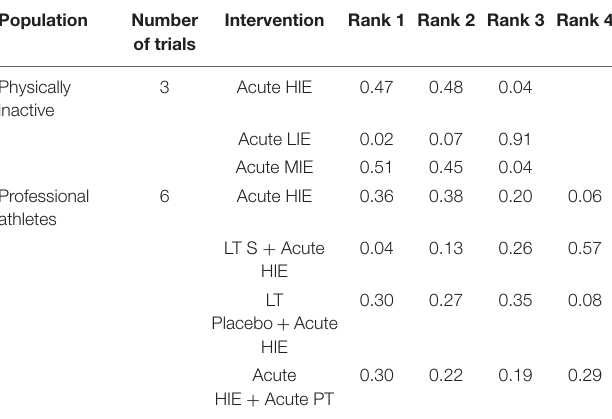
TABLE 5 | The random-effects standard deviation of mixed interventions comparisons under consistency and inconsistency models.